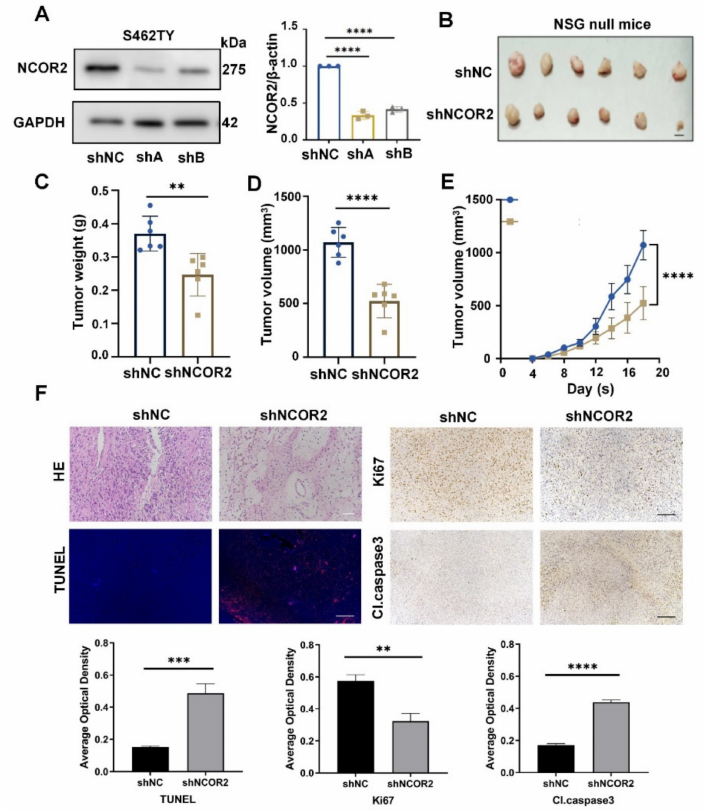
Figure 3. NCOR2 knockdown reduced the tumourigenicity of NF1-derived MPNST cells in vivo. ( A ) WB showing that the efficacy of NCOR2 knockdown in S462TY cells at protein levels; shA was selected for further transplantation. GAPDH was used as the control. Data are shown as mean ± S.D., n = 3; **** p < 0.0001. ( B – E ) The S462TY-shNCOR2 group displayed significant reductions in tumour size and weight. Data are shown as mean ± S.D., n = 6; ** p < 0.005, **** p < 0.0001. ( F ) HE and IHC showing that the density of tumour cells was reduced, the positive expression of Ki67 was decreased and cleaved-caspase 3 was increased in S462TY-shNCOR2 group; TUNEL staining showing increased apoptotic cells in S462TY-shNCOR2 group. Scale bar, 50 µ m. Data are shown as mean ± S.D., n =